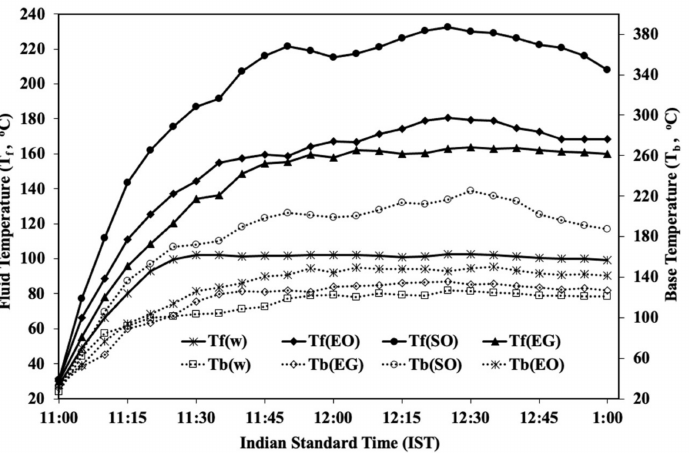
Figure 4. Thermal profiles of different heat transfer fluids (EO 15 November, EG 17 November, SO 20 November, and Water 23 November 2021) of capacity 0.5 L each in dish concentrator receiver ( T b and T f are receiver base and average fluid temperature,